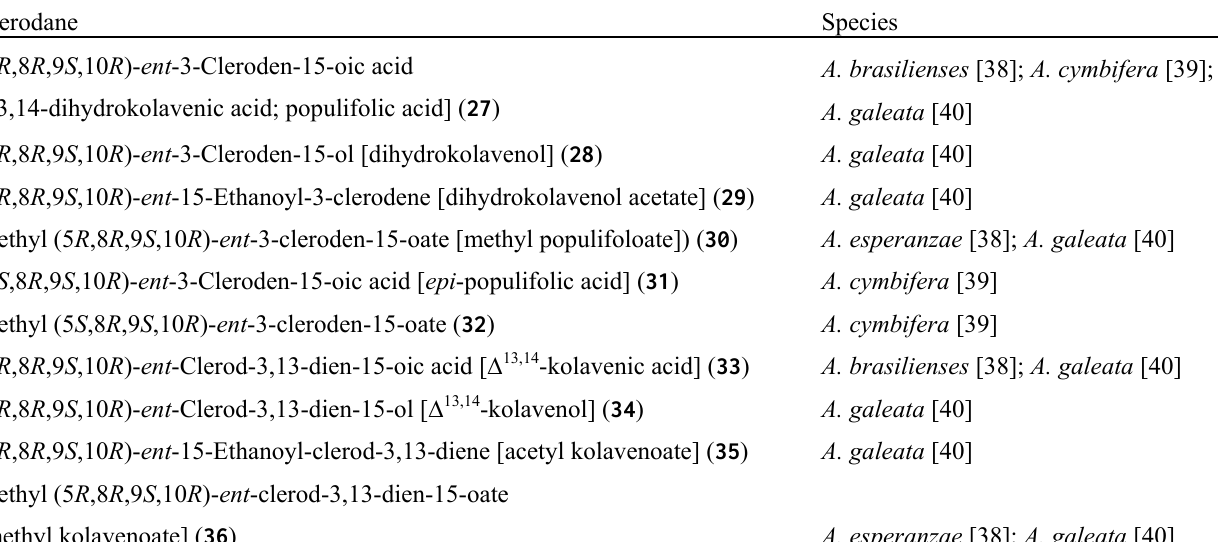
Table 2. Clerodane diterpenoids isolated from Aristolochia